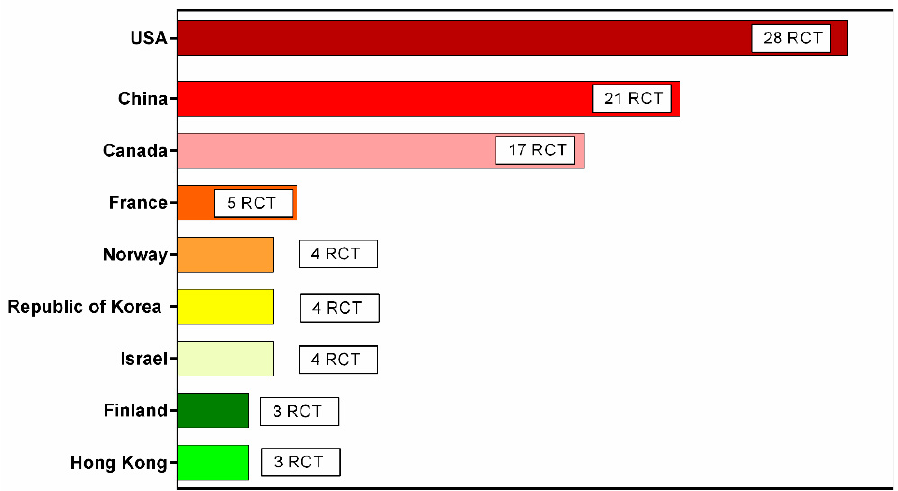
Figure 2. List of countries with the most active contributions in FMT investigation.